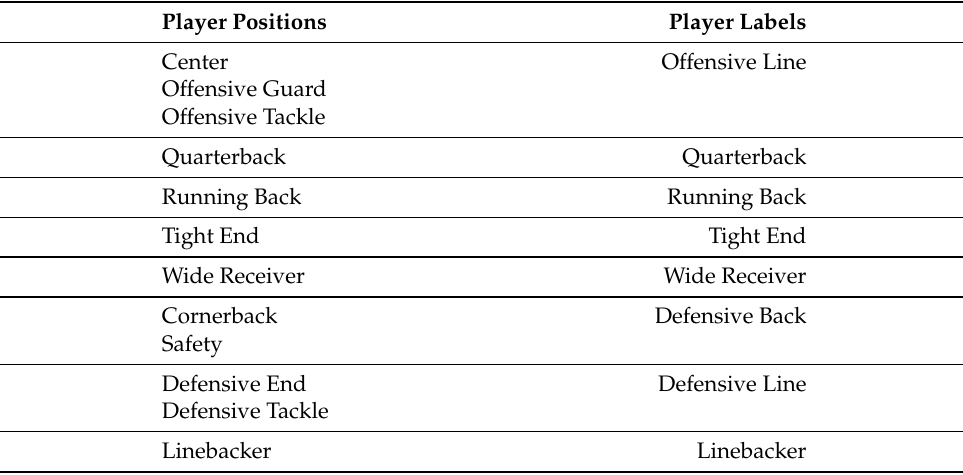
Table 1. Twelve player positions are grouped into eight groups or labels for classification. Player